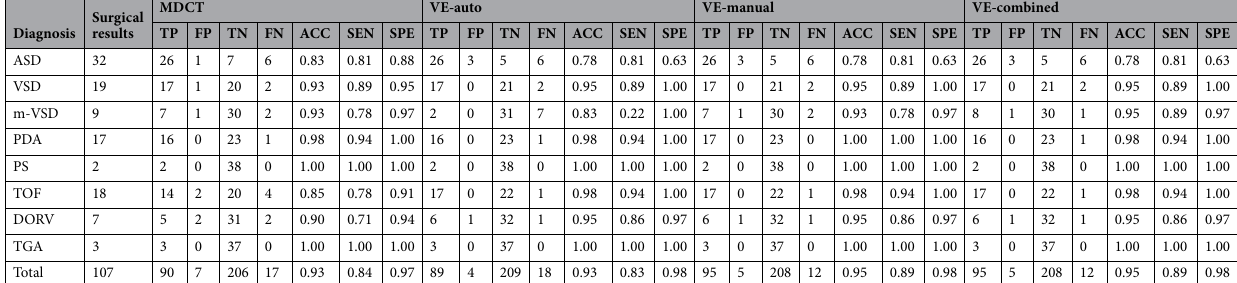
Table 3. Diagnostic performance on CHDs by MDCT and VEs. ASD, Atrial septal defect; VSD, Ventricular septal defect; m-VSD, Muscular ventricular septal defect; PDA, Patent ductus arteriosus; PS, Pulmonary Stenosis; TOF, Tetralogy of Fallot; DORV, Double outlet right ventricle; TGA, Transposition of Great Artery; TP, true positive value; FP, false positive value; TN, true negative value; FN, false negative value; ACC, accuracy; SEN, sensitivity; SPE, specificity.